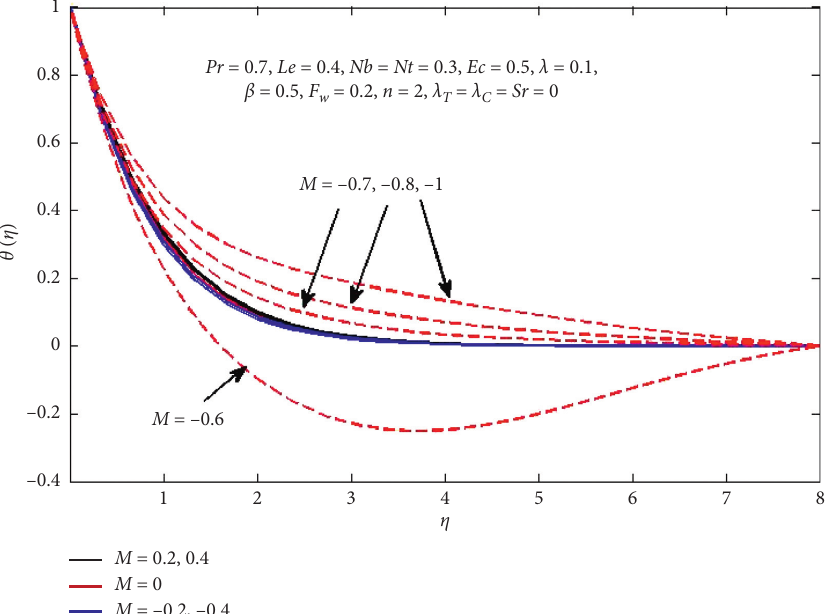
Figure 15: Variation of temperature θ concerning η with various values of M .